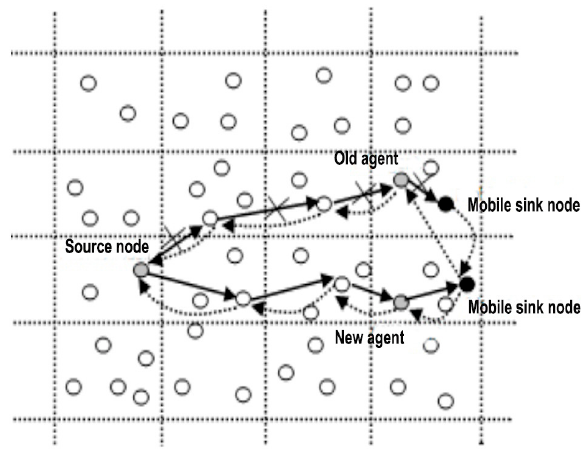
Figure 2. Mobile sink node in the IoT.